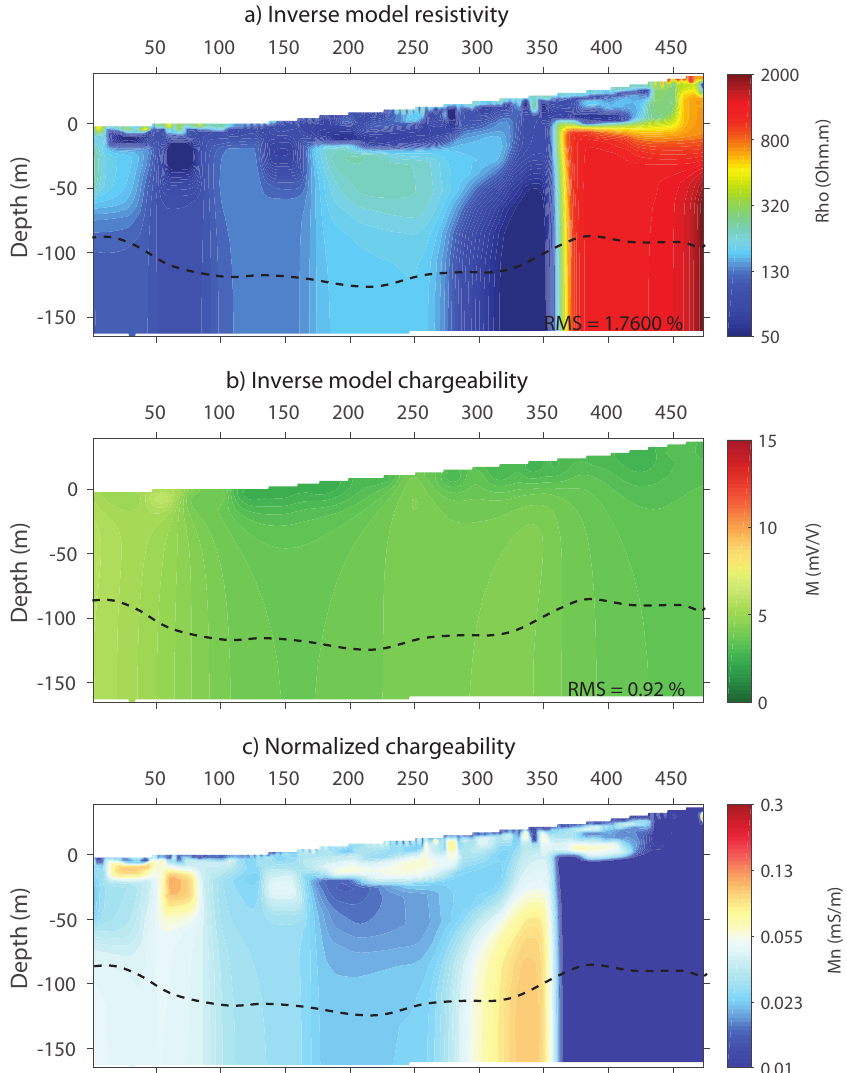
Figure A2. Resistivity, chargeability and normalized chargeability distributions obtained in the same area as profile 2. The dashed black line indicates the limit below which the DOI index value exceeds the trust threshold value of